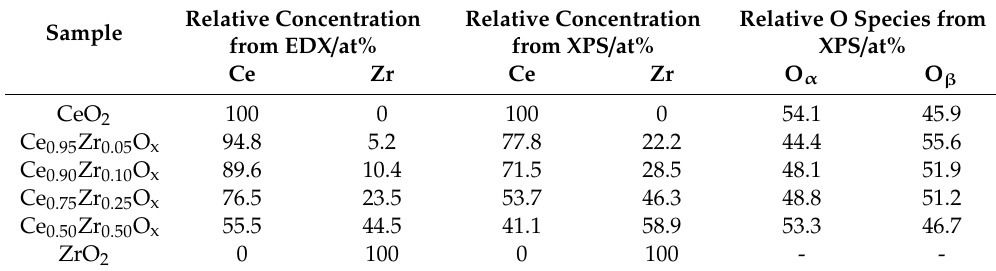
Table 3. EDX and XPS derived elemental concentrations for the ceria–zirconia mixed metal oxides. Relative Concentration Relative Concentration Relative O Species from Sample from EDX / at% from XPS / at% XPS / at% Ce Zr